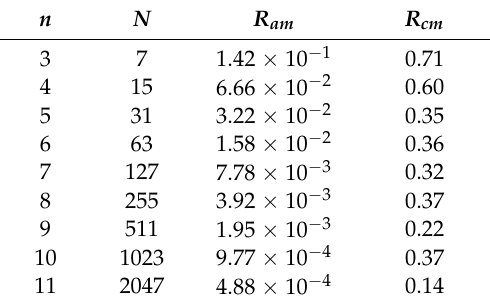
Table 1. The autocorrelation of